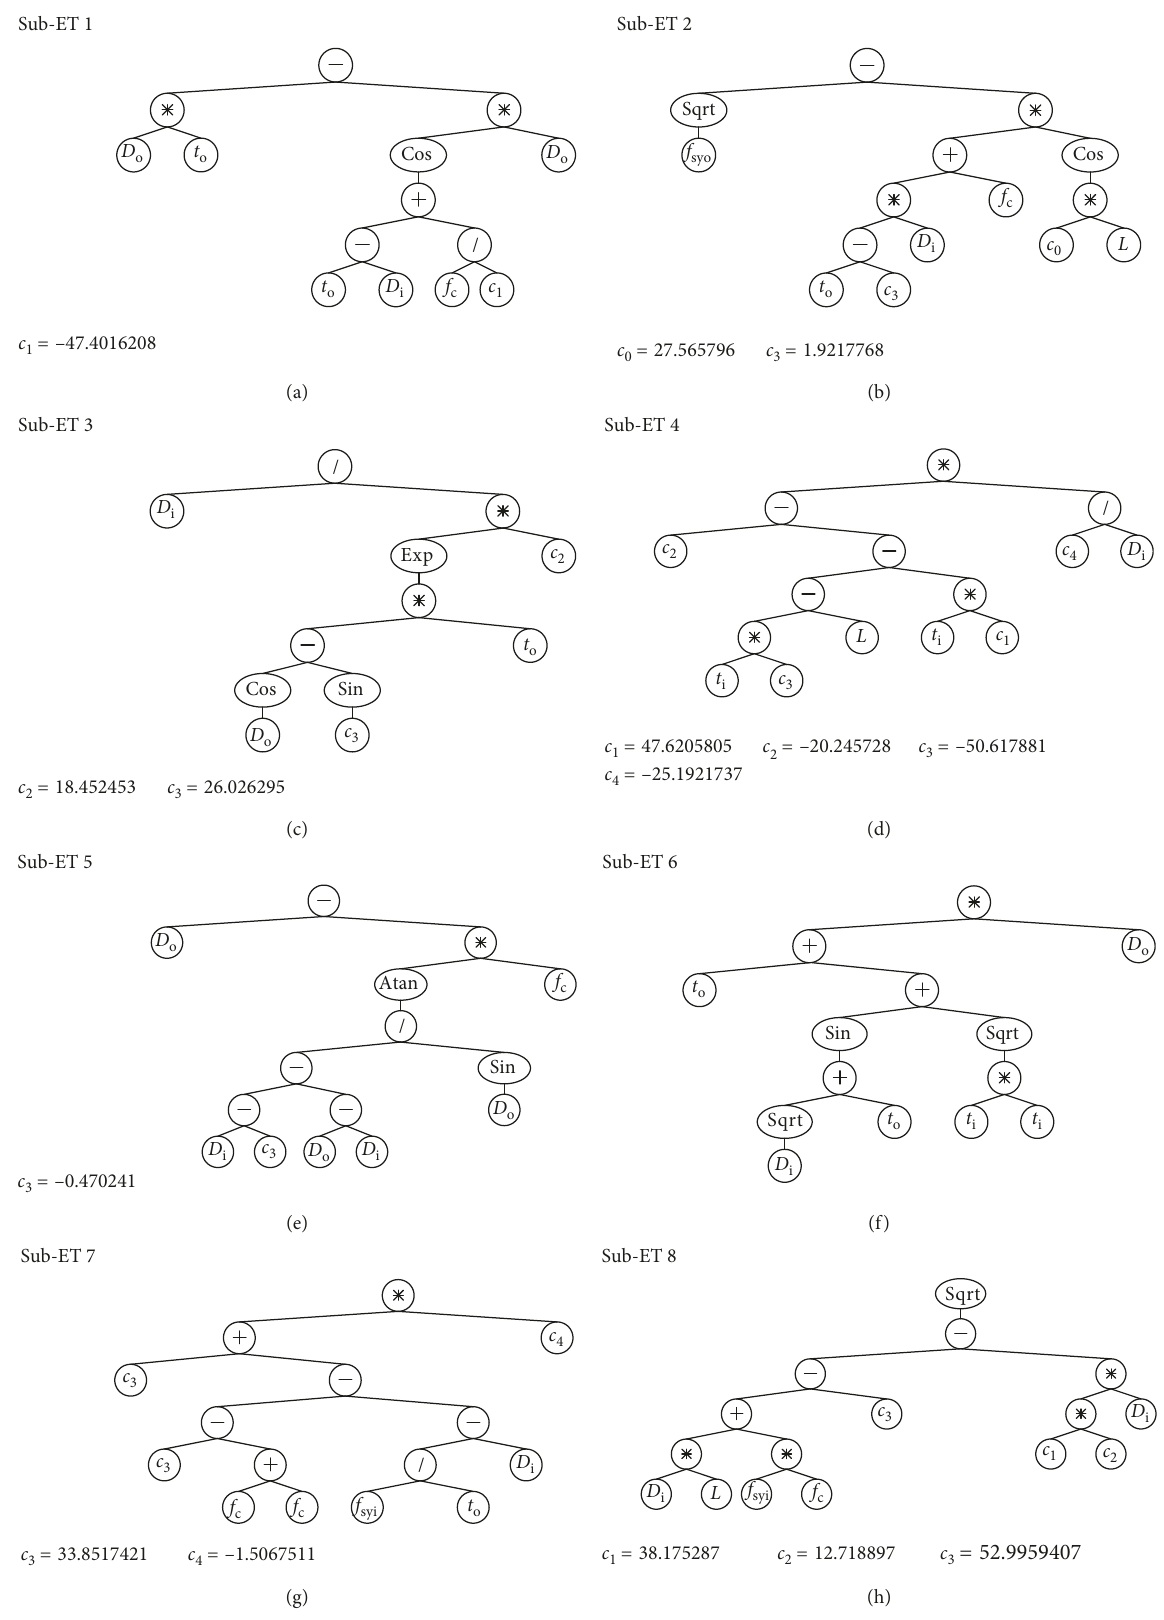
Figure 3: Expression trees for the proposed model. (a) Function 1. (b) Function 2. (c) Function 3. (d) Function 4. (e) Function 5. (f) Function 6. (g) Function 7. (h) Function